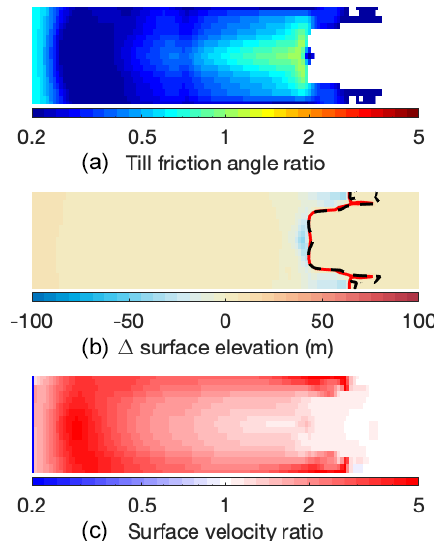
Figure 8. Errors in inverted bed roughness (a) , surface elevation (b) , and surface velocity (c) for the non-equilibrium target inversion. The grounding line in the target (inverted) geometry is indicated by a solid red (dashed black)